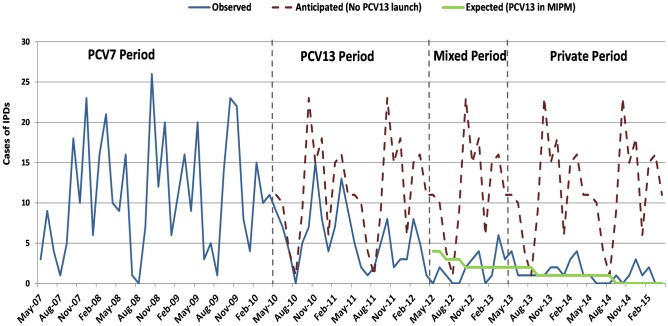
Evolution of cases of invasive pneumococcal disease (IPD) caused by serotypes included in the 13-valent pneumococcal conjugate vaccine (PCV13).Estimated evolution of PCV13-type IPD in relation to PCV13 introduction using the Holt-Winters exponential smoothing.